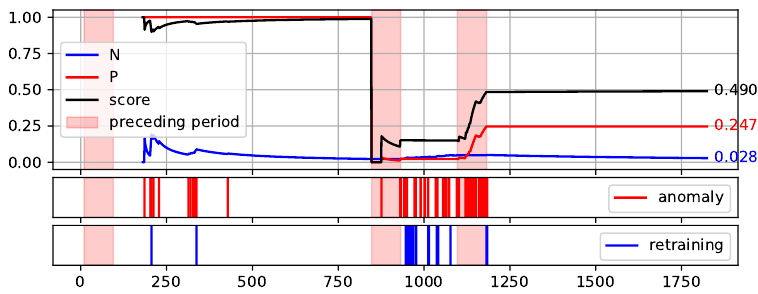
Figure 10. Plot of the values of each measure (P, N, and Score) over consecutive aggregation windows for HDBSCAN execution on the S201 data set.